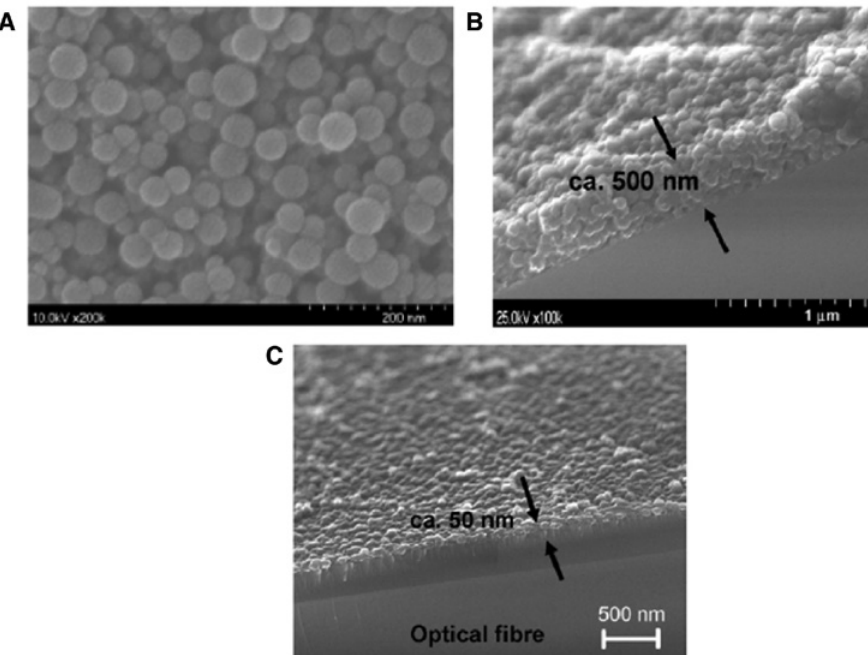
) film overlay deposited on a quartz substrate 2